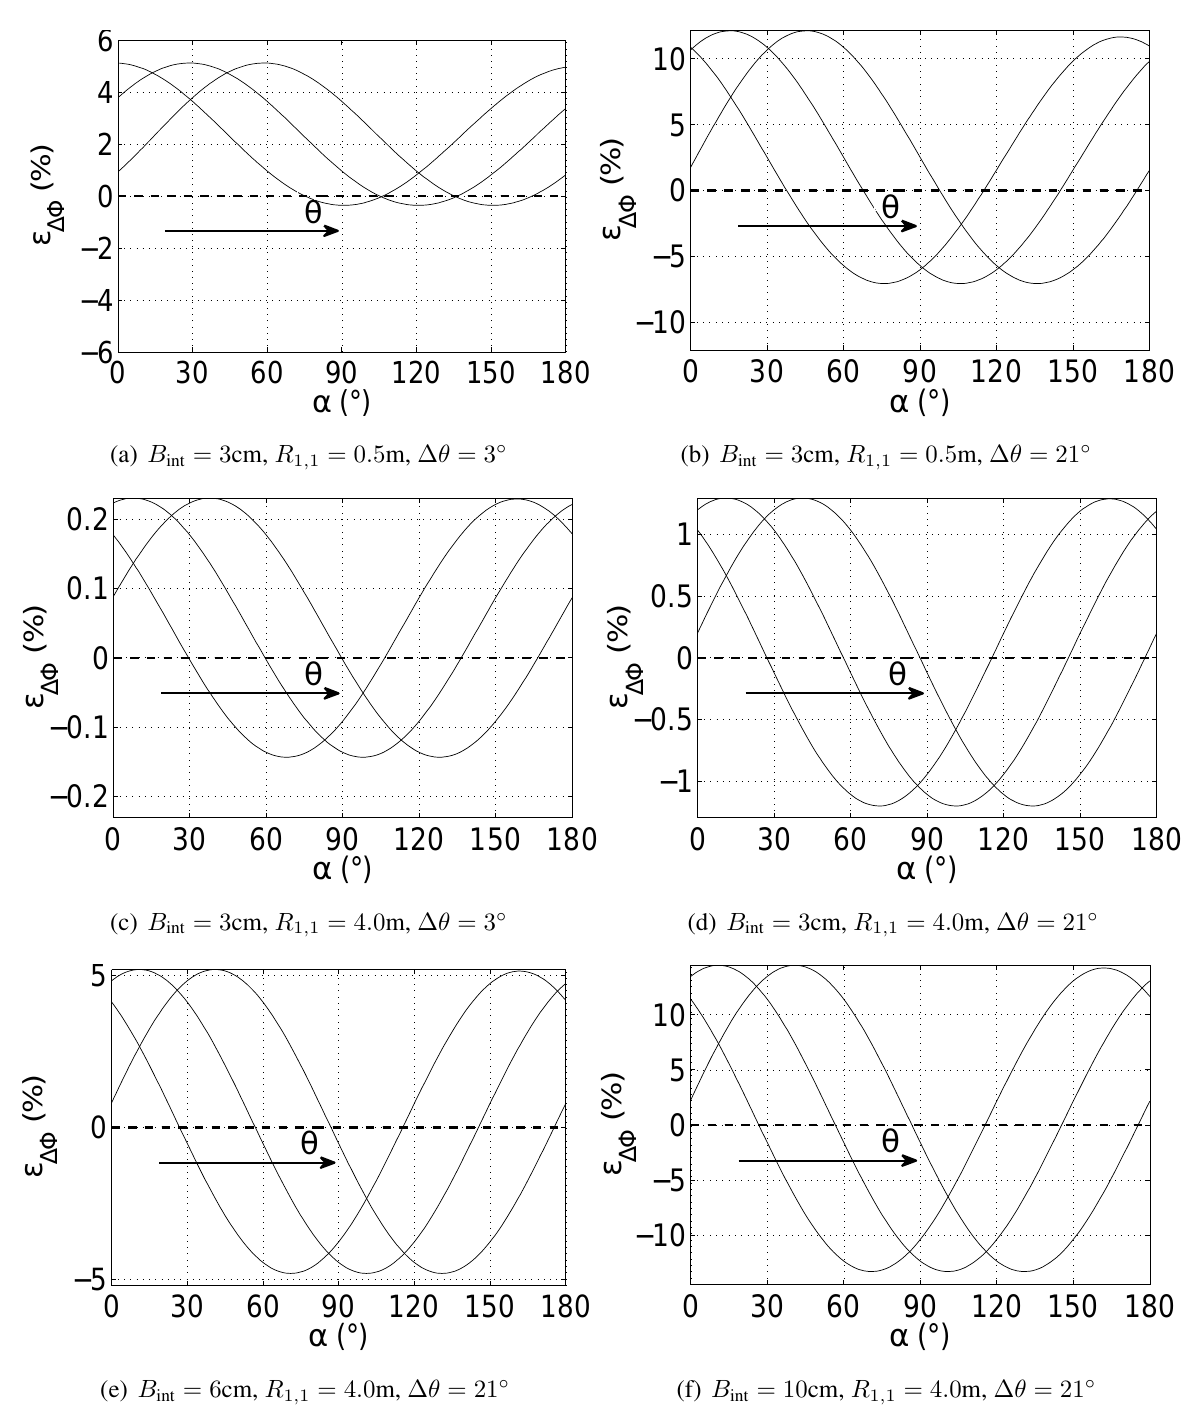
Figure 6. Percentage error between the true and approximated differential interferometric phases under various operating conditions (the three curves correspond to θ = 15 ◦ , θ = 45 ◦ , θ = 75 ◦